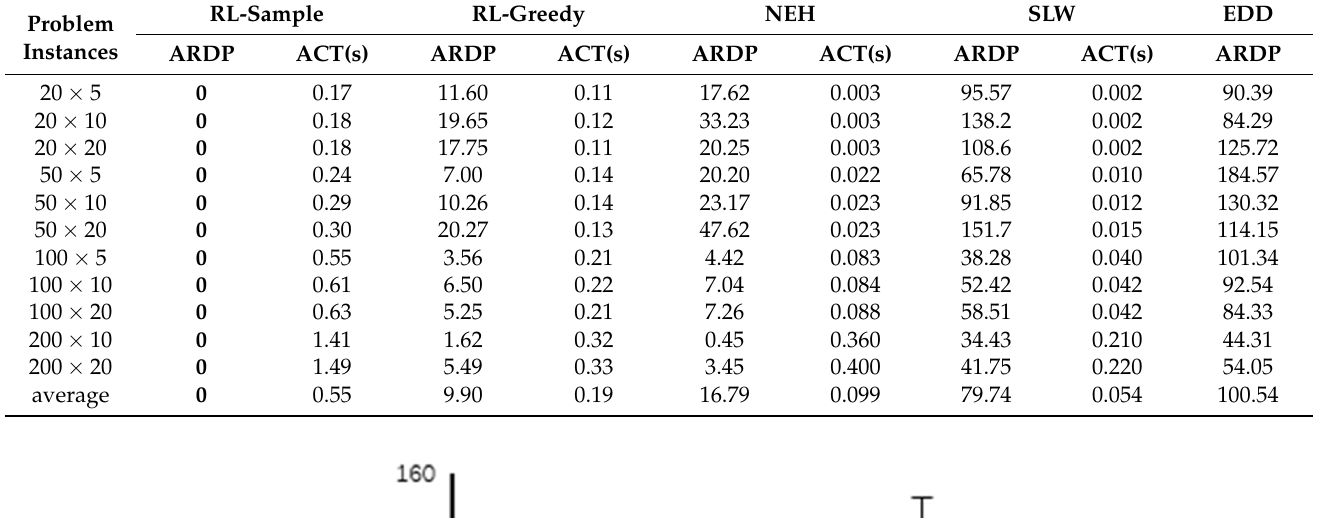
Table 5. Comparison of RL and multiple heuristic algorithms.